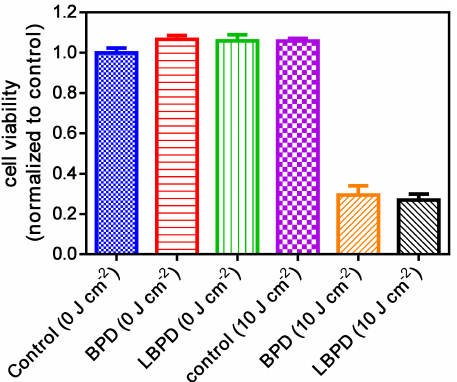
Fig. 4. HeLa cells survival 1 day post-PDT. PDT experiments were performed in triplicate and the data were expressed as mean plus and minus the